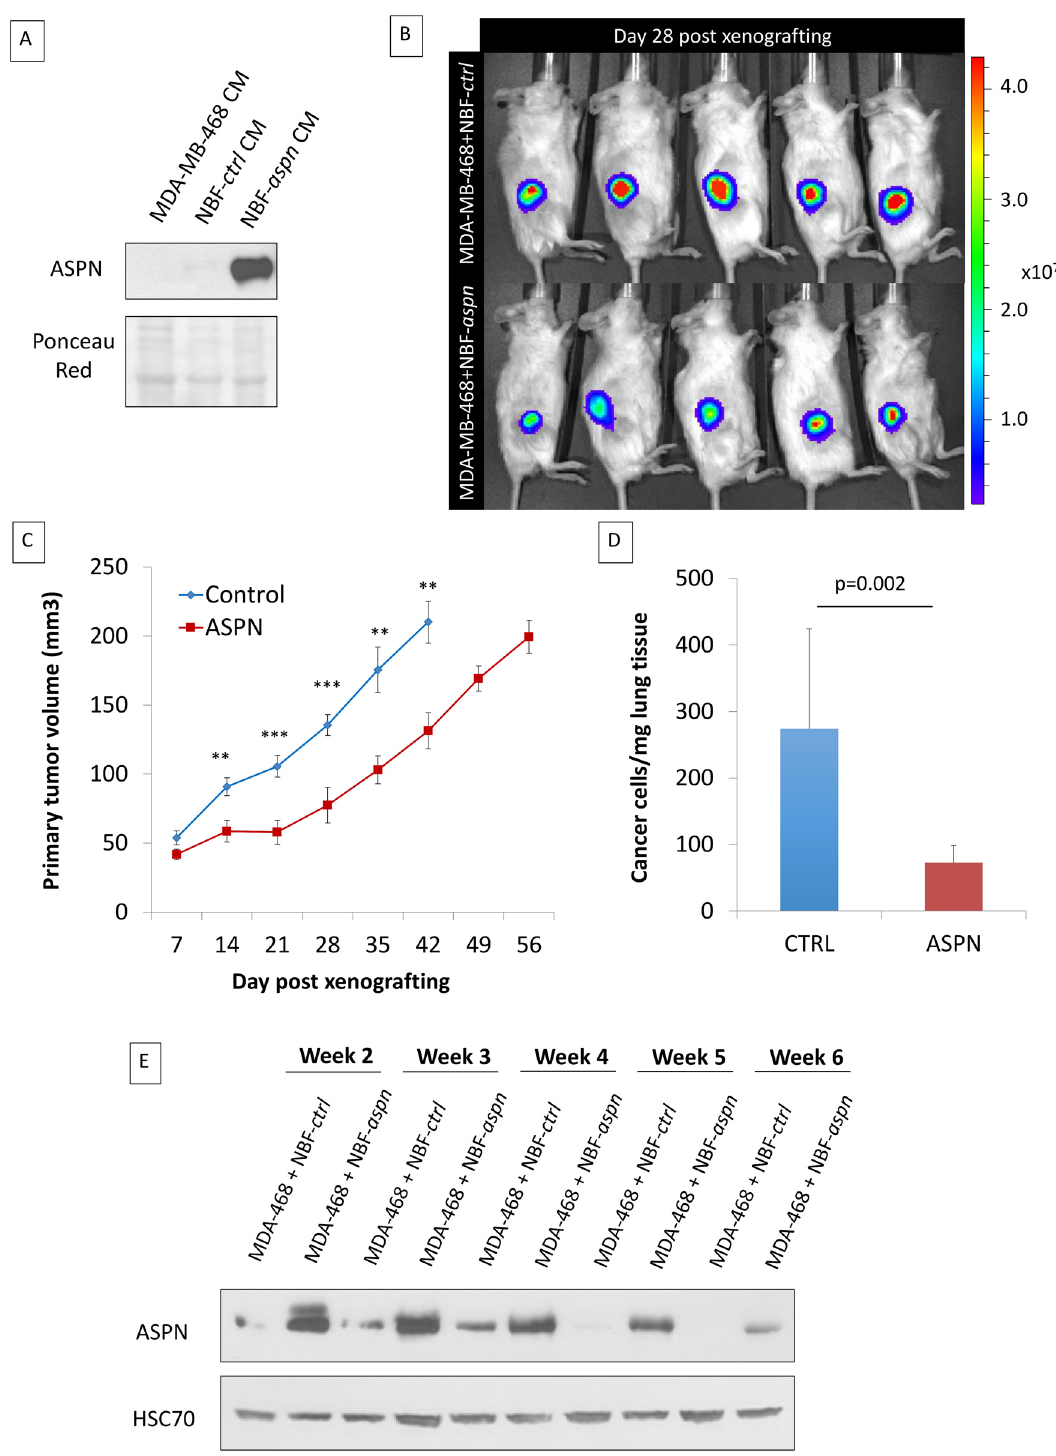
Fig 5. Co-injection of cancer cells and fibroblasts overexpressing asporin reduces primary breast cancer tumor growth and lung metastasis formation in vivo. (A) Western blot analysis of asporin expression in CM of MDA-MB-468 cells and in NBF stable clones used for subcutaneous injection in mice. Ponceau red is shown as loading control. (B) Bioluminescence imaging of control and asporin-expressing xenografts at day 28 after tumor engraftment. The color scale indicates the fluorescent intensity. (C) The volume (in cubic millimeters) of primary tumors measured weekly (from day 7 onwards). The data are presented as mean ± standard error of the mean (SEM) ( n = 10 for each group). Statistical significance was calculated